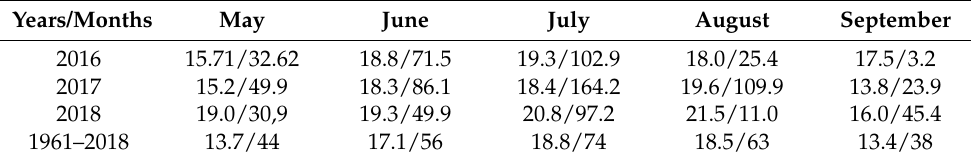
Table 3. Weather conditions during consecutive years of tomato